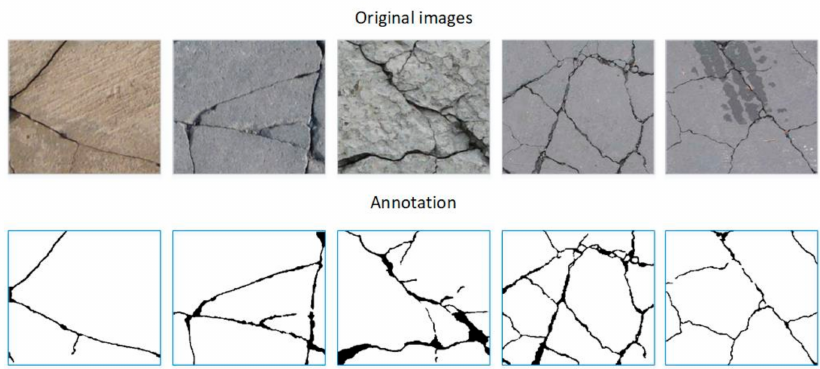
Figure 2. The public concrete crack dataset collected by Yang et